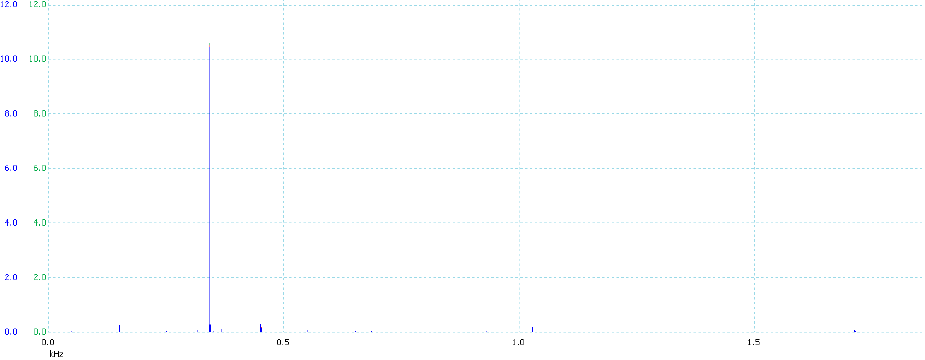
Figure 22. AFPMA phase voltage THD % experimental result at m N = 5000 RPM.